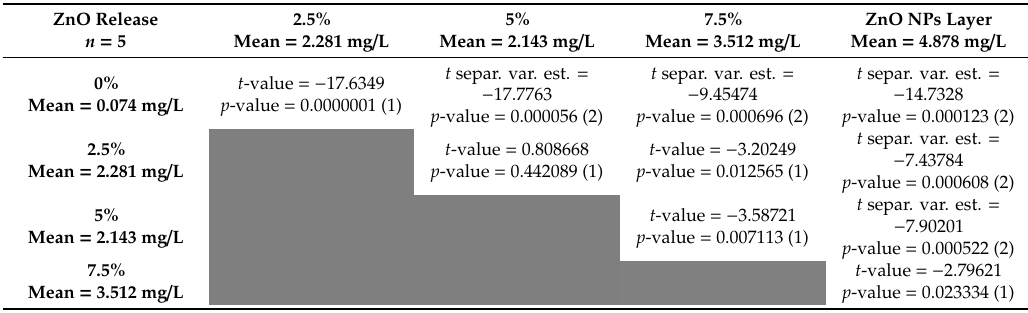
Table 2. Results of the ZnO release from nanocomposites: (1) Student’s t -test for independent samples; (2) Cochran–Cox test with separate variance estimate